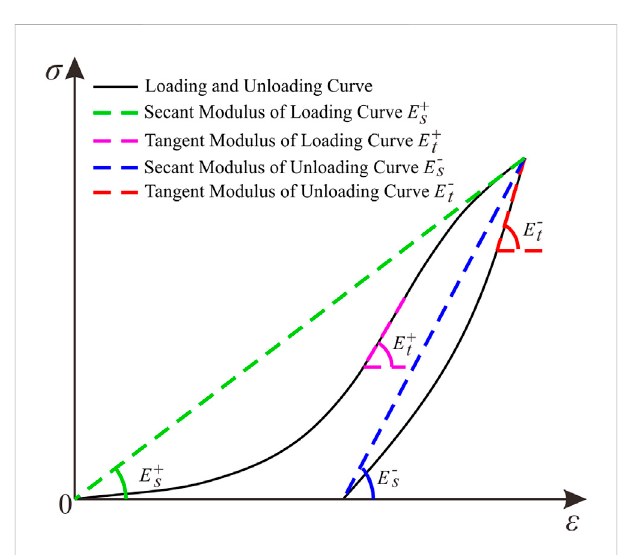
FIGURE 2 Schematic diagram of different calculation methods for elastic